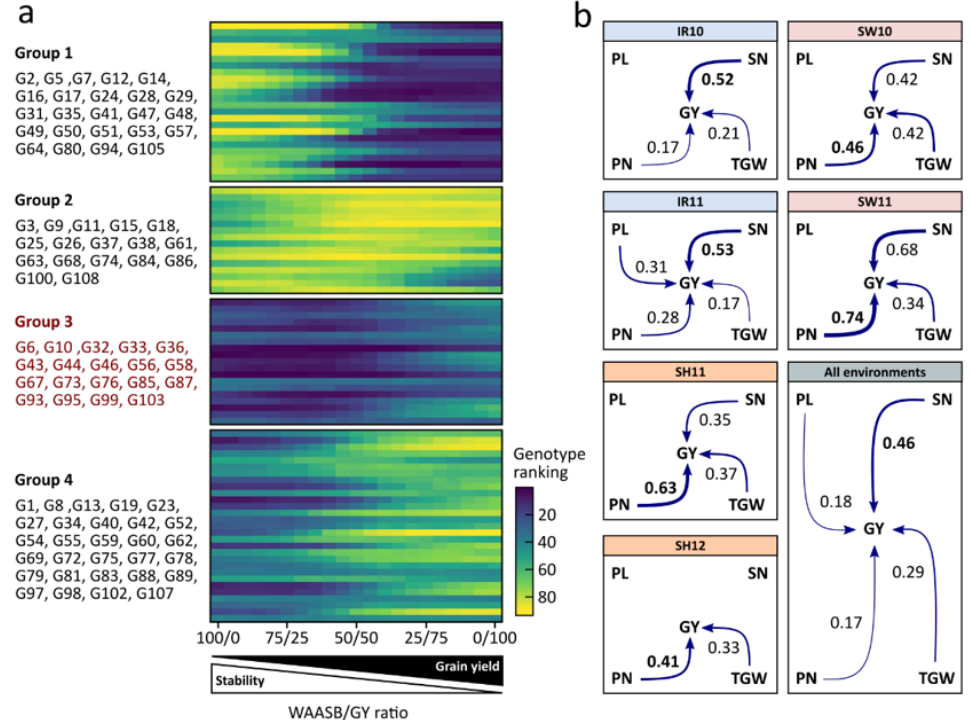
Figure 5. Grain yield performance and stability across all environments. ( a ) Rank of 89 genotypes according to different weightings of stability and grain yield performance. The order of the genotype codes in each group corresponds to the order of the heatmap (top-to-bottom). ( b ) Path analyses between yield-related traits and grain yield. Numerical values show standardized path coefficients, and line thickness represents the strength of the direct effect. Individual trials are shown as location-year combinations. IR, IRRI, Los Baños; SH, Shanghai; SW, Suwon. Suffixes 10, 11, and 12 indicate trials in 2010, 2011, and 2012, respectively. PL, panicle length; PN, panicle number; SN, spikelet number per panicle; TGW, thousand-grain weight; GY, grain yield.